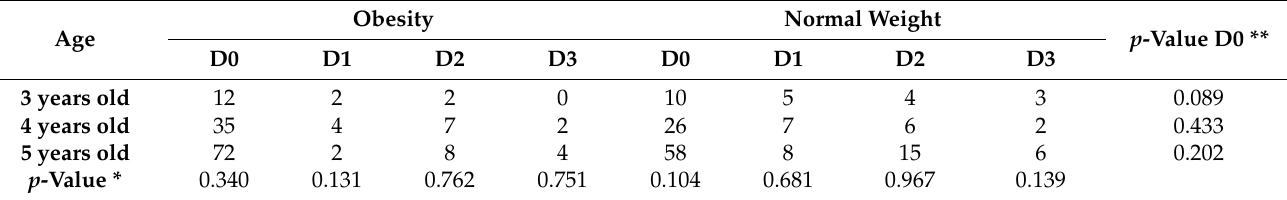
Table 4. Effectiveness of treatment after 6 months by age.